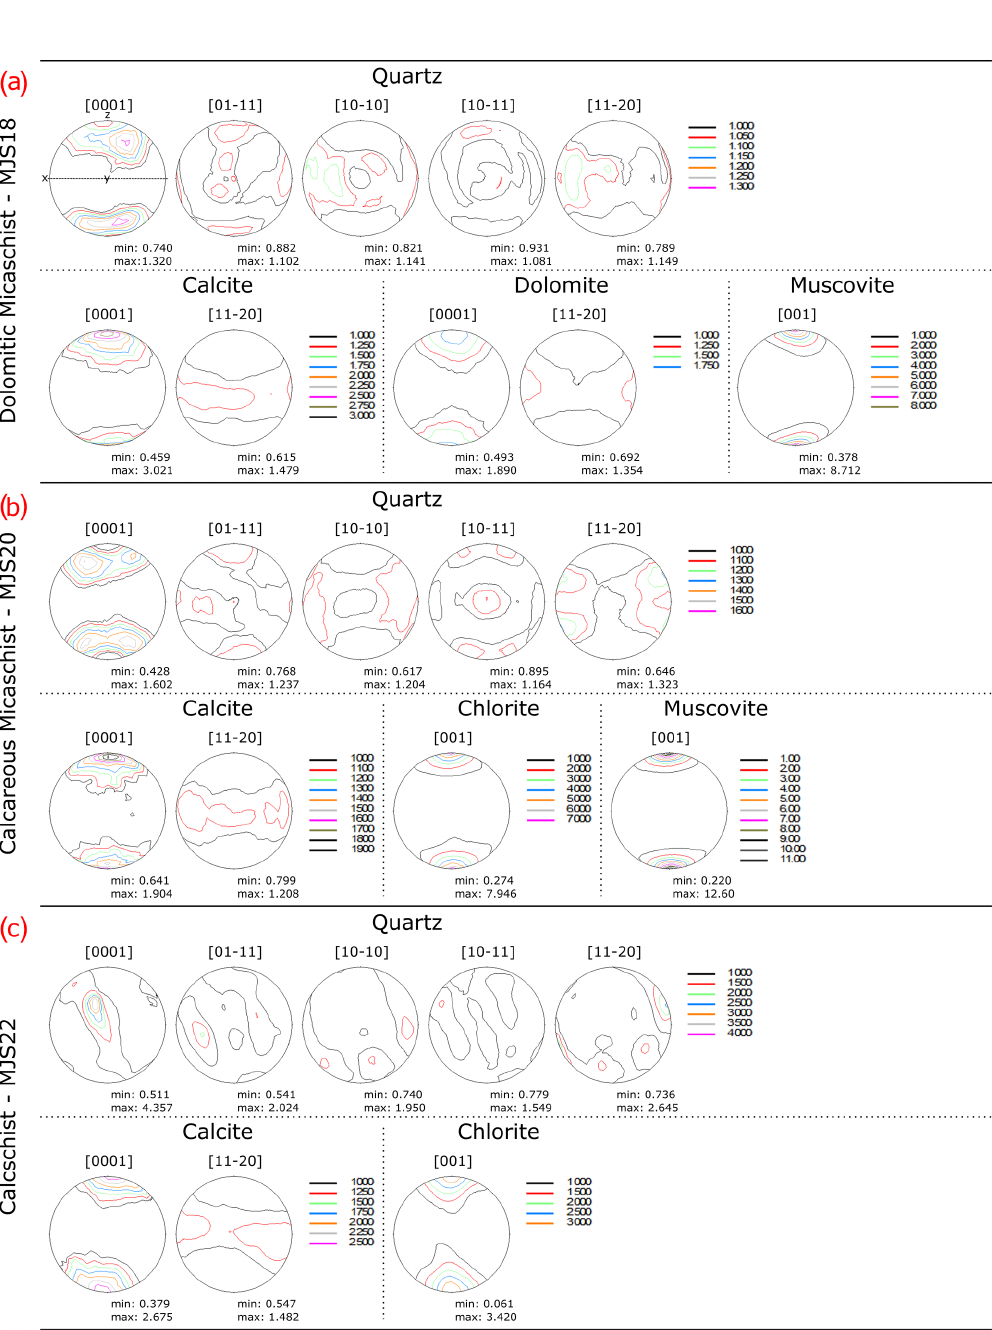
Figure 6. Calculated pole figures of important mineral phases in the dolomitic micaschist ( a ; MJS18), the calcareous micaschist ( b ; MJS20) and the calcschist ( c ; MJS22). The stretching lineation (kinematic x direction) is oriented EW in the pole figures, the foliation normal (kinematic z direction) is oriented NS and the kinematic y direction (perpendicular to x and z directions) is normal to the pole figure plane. The pole figures are lower hemisphere equal area projections. The contour levels display multiples of random distribution, and minimum and maximum values are listed below the pole